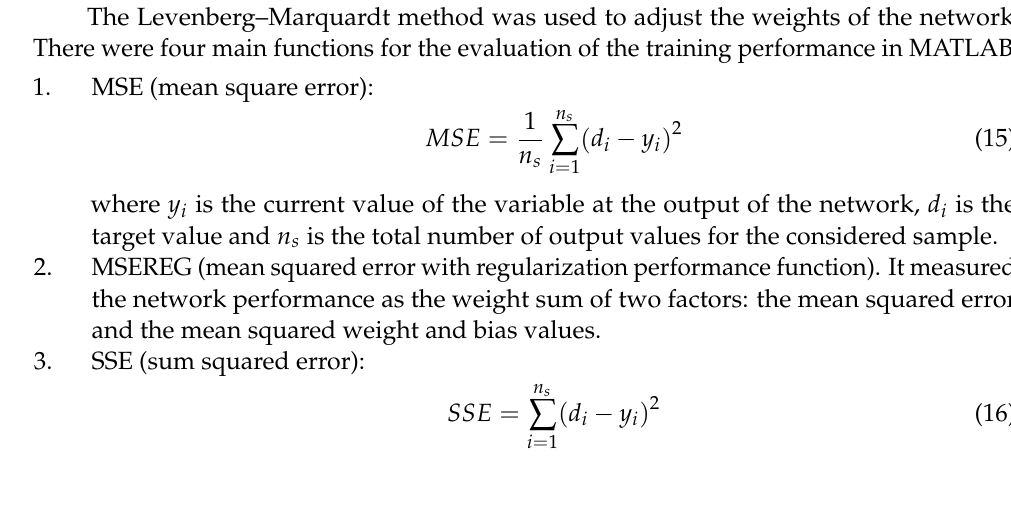
Figure 3. Neural network architecture.